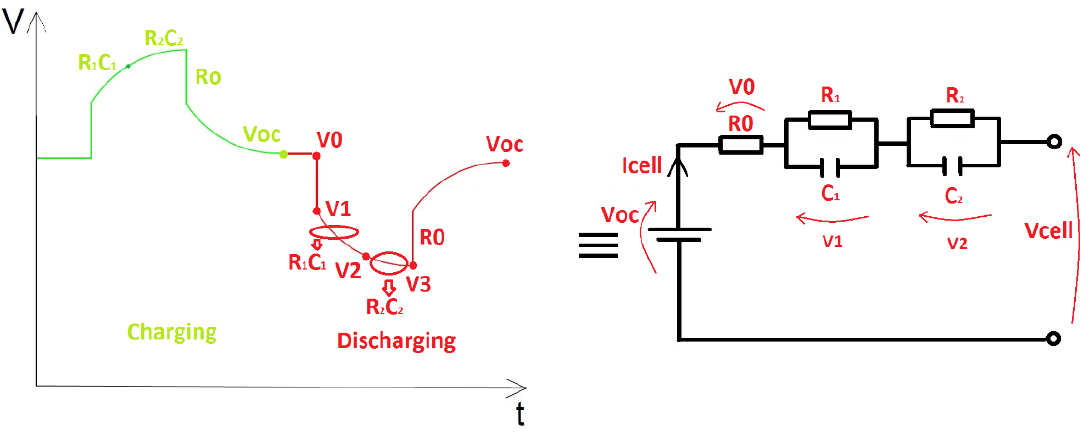
Figure 2. The voltage response of the cell and its second order EEC.